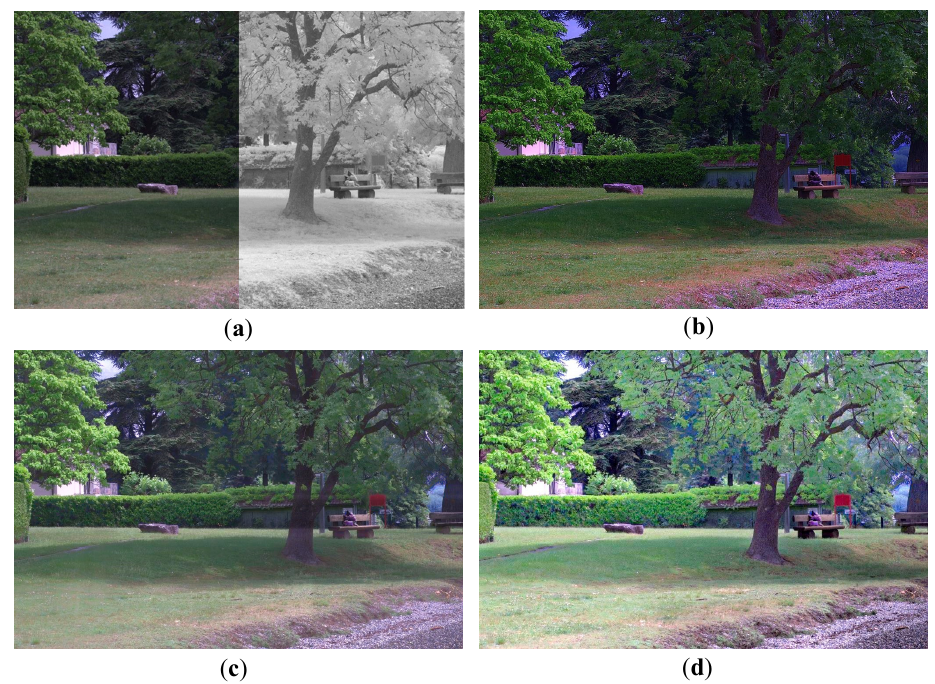
Figure 12. Input image pair and resulting images: (a) input VIS and NIR images, (b) Laplacian pyramid fusion [1], (c) low-rank fusion [5], and (d) the proposed method.